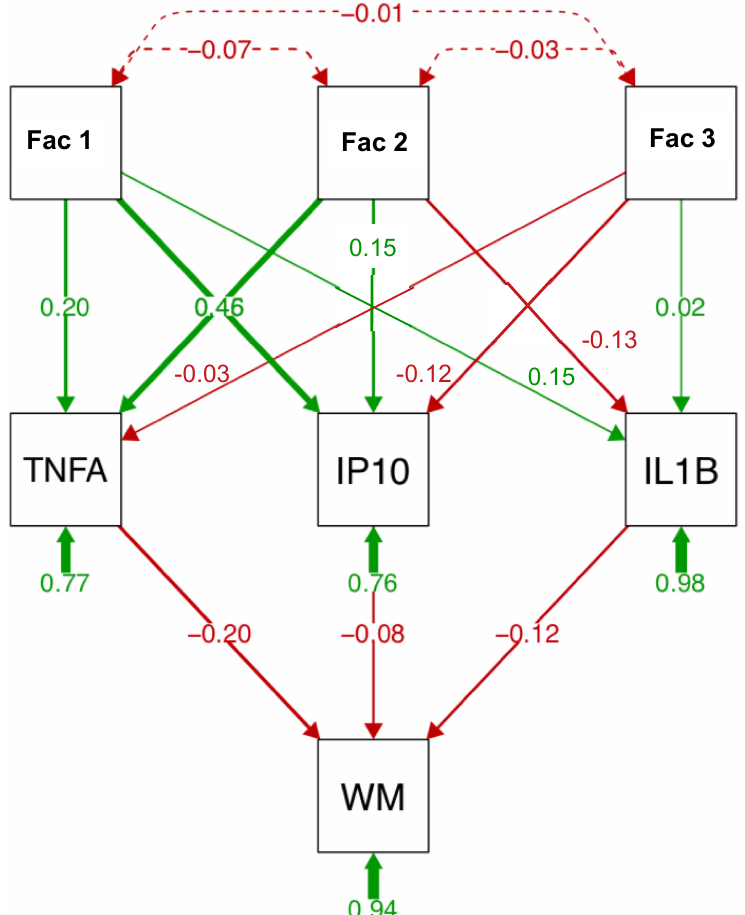
Figure 4. Path analysis describing relationships between relevant variables, soluble protein levels, and subcortical white matter volume (WM). Path analysis includes 3 factors (reduced from 15 variables entered into principal component analysis (PCA)), 3 soluble proteins, and subcortical white matter in the HCV and HIV groups ( n = 127). Factor 1 (6 variables) includes HCV viral load, fibrosis score (FIB4), aspartate aminotransferase/platelet count ratio (APRI), aspartate aminotransferase (AST), alanine aminotransferase (ALT), and γ -glutamyl transferase (GGT). Factor 2 (5 variables) includes injection drug use (IDU), VACS index, creatinine, estimated glomerular filtration rate (eGFR), and prealbumin. Factor 3 (3 variables) includes HIV viral load, total HIV conditions, and the albumin-to-globulin ratio (AGR).